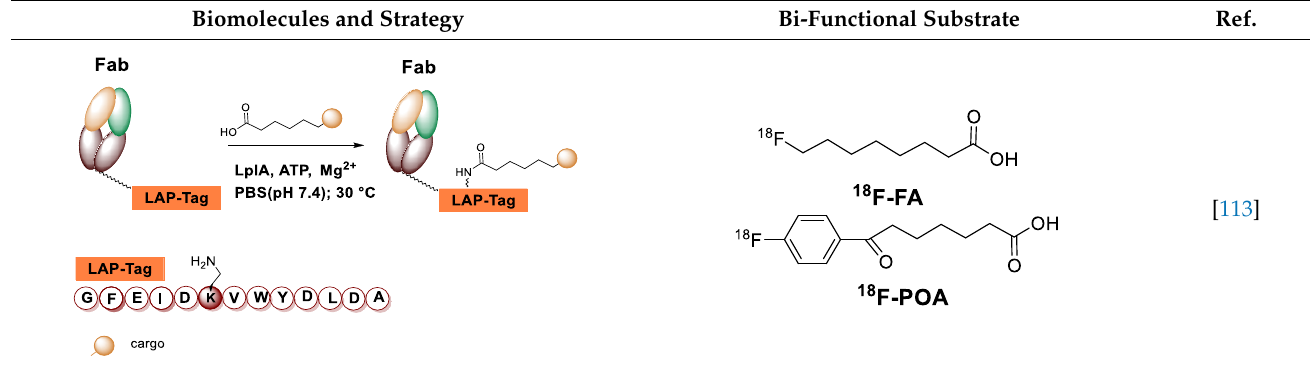
Table 8. Overview of lipoic acid ligase mediated conjugation in radiopharmaceutical applications. Biomolecules and Strategy